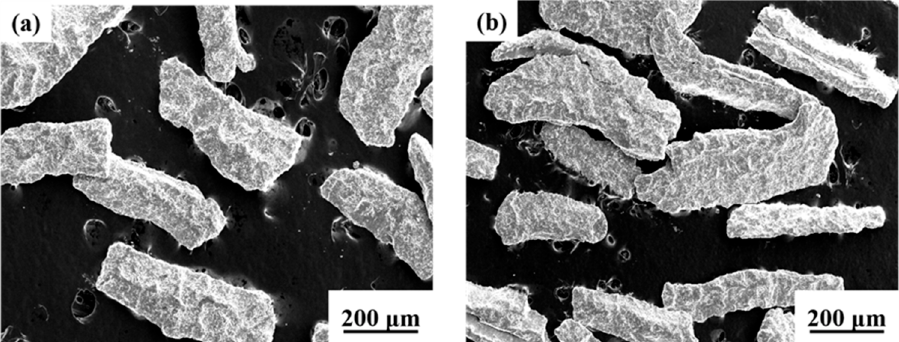
Figure 4. The powder morphology of AZ31 Mg alloy with different V P content after milling for 50 h: ( a ) 7.5 wt %, ( b ) 10 wt %.